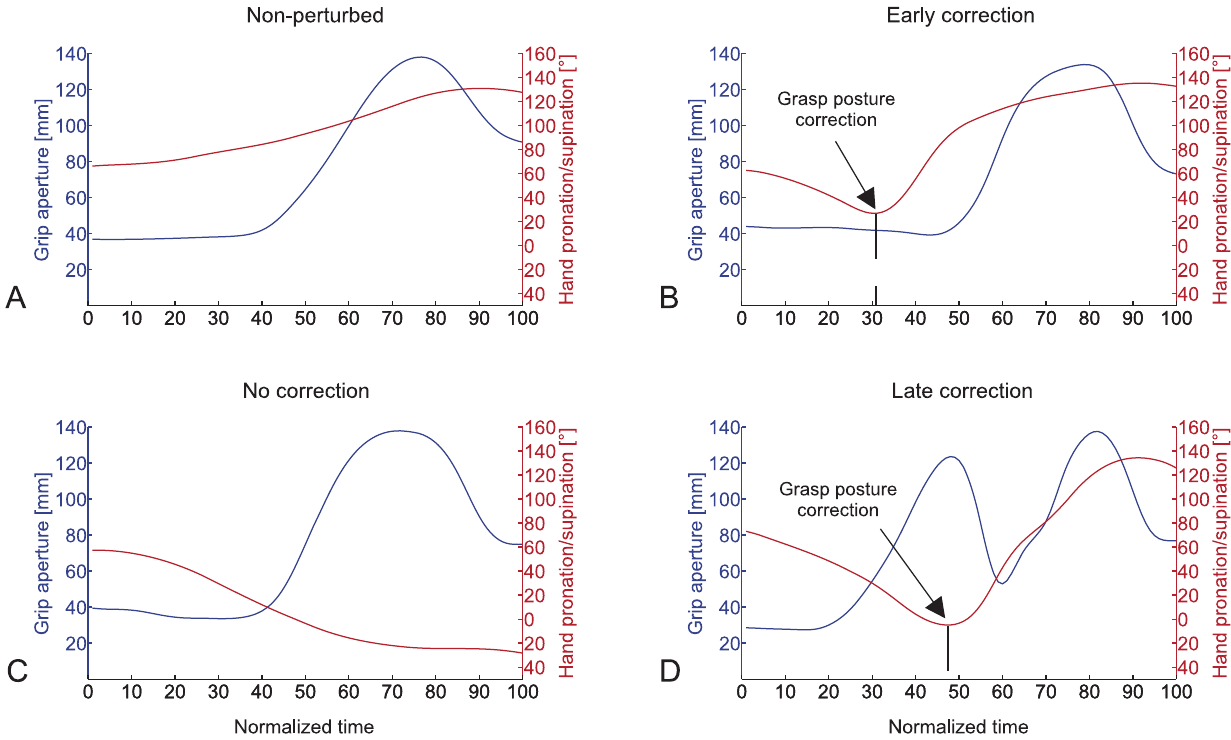
Figure 4. Representative grip aperture and hand orientation profiles for during the reach-to-grasp phase for A) non-perturbed trials, B) early correction perturbed trials, C) no-correction perturbed, and D) late correction perturbed trials. Corrections in grasp posture occurred at 30.1% of normalized reach-to-grasp time for early correction trials (panel C), and 45.9% of normalized reach-to-grasp time for late correction trials (panel D). Depicted are representative profiles for final left end-down trials. The pattern of grip aperture and hand orientation profiles are similar to final right end-down trials, with the exception that the hand orientation became more pronated throughout the reach-to-grasp phase.